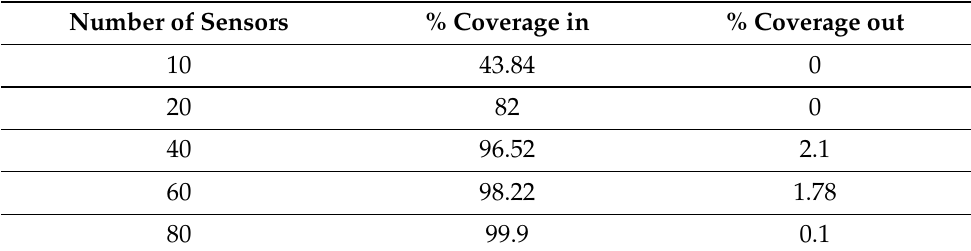
Table 2. Coverage percentage.